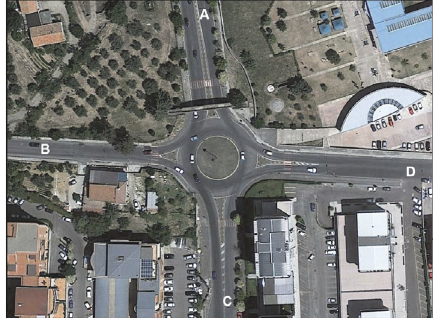
Figure 1: Aerial image of Marconi Roundabout.